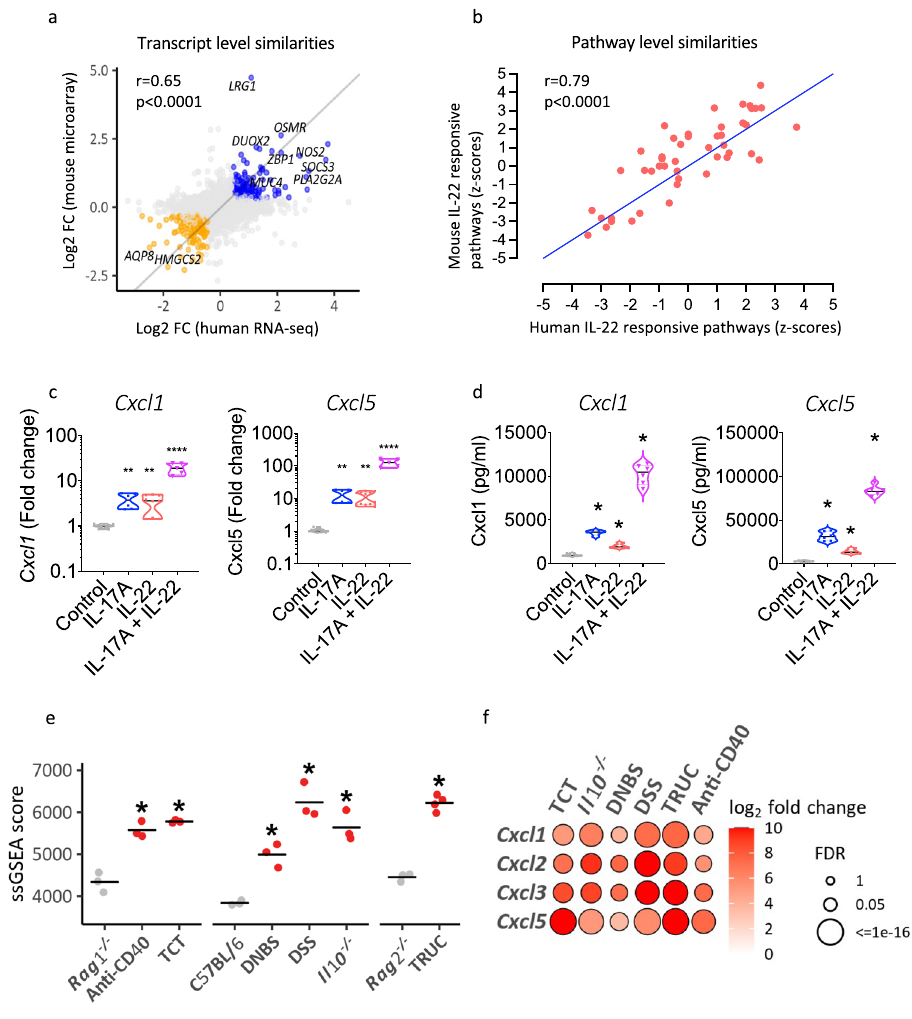
Fig. 5 | IL-22 mediated remodeling of the colonic epithelial transcriptome is conserved across species at gene and pathway level. a Non-parametric (Spear- man, two-tailed) correlation of transcripts regulated by IL-22 in human and mouse colonoids (FC fold change) [ r =0.65, (0.60, 0.71), p <0.0001], b non-parametric (Spearman, two tailed) correlation of pathways regulated by IL-22 in human and mousecolonoids(z-scoresderived fromIngenuityPathwayAnalysis- IPA)[ r =0.79, (0.64, 0.88), p <0.0001], c effects of IL-22, IL-17A and their combination to the regulation of the neutrophil attracting chemokines Cxcl1 and Cxcl5 expression in mouse colonoids, ( n =12, Kruskal – Wallis with Dunn ’ s multiple comparisons test, ** p <0.01, **** p <0.0001, median denoted with blackline), d effects of IL-22, IL-17A and their combination to the production of the neutrophil attracting chemokines Cxcl1 and Cxcl5 in mouse colonoids ( n =6, paired Wilcoxon, two tailed test, all comparisons against control, * p =0.31, median denoted with black